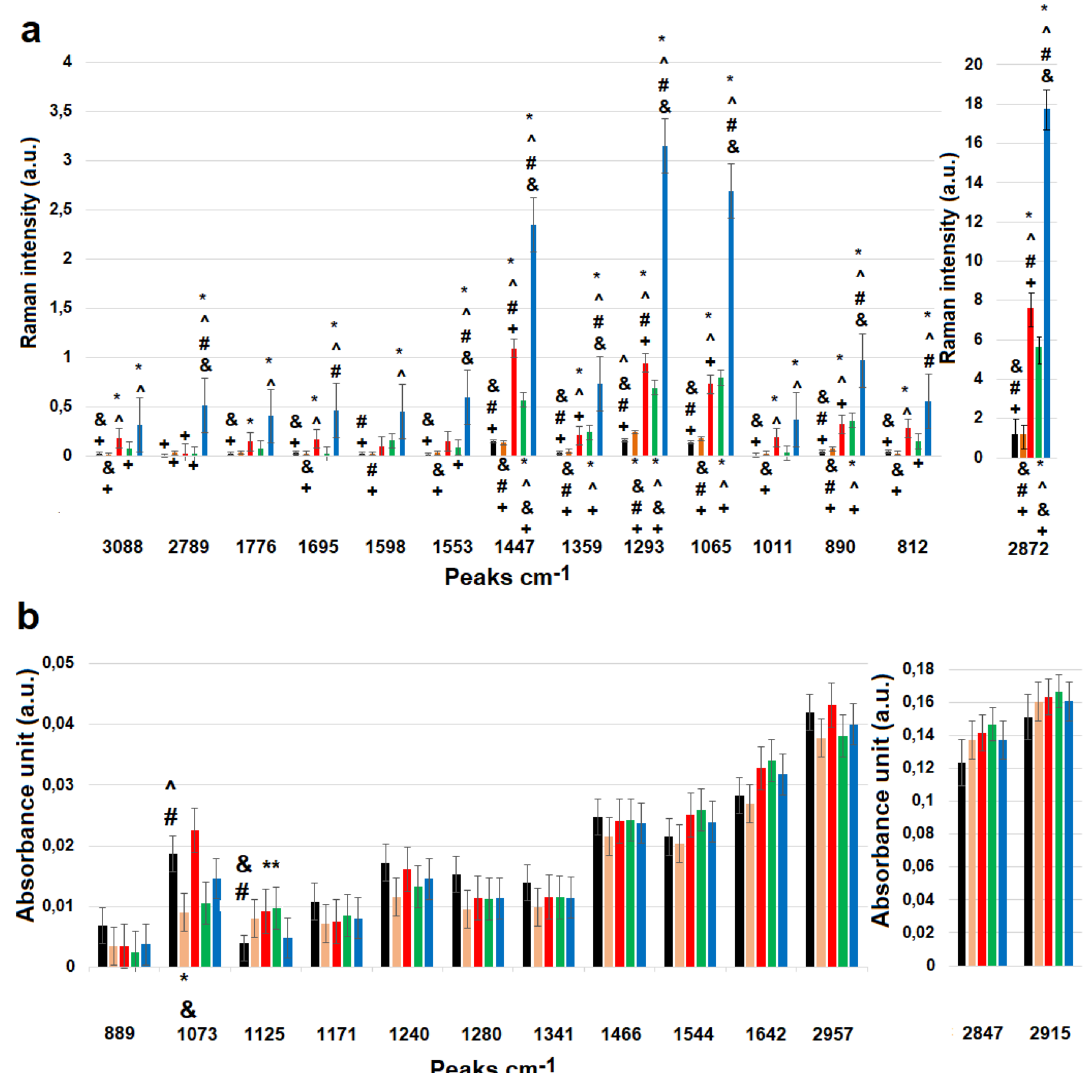
Figure 3. Mean ± standard error of the mean (SEM) intensity values of the individual peaks measured with Raman ( a ) and FTIR ( b ) for all groups of tissue samples, where color bars stand for: control (black spectrum); atrophic endometrium (orange spectrum); complex atypical hyperplasia (red spectrum); endometrial polyp (green spectrum); endometrioid adenocarcinoma (blue spectrum). Data was analyzed using one-way ANOVA followed by Tukey’s post hoc test. Statistical significance was adopted at * p < 0.05 versus Control; ^ p < 0.05 versus atrophic endometrium; & p < 0.05 versus complex atypical hyperplasia; # p < 0.05 versus endometrial polyp; + p < 0.05 versus endometrioid